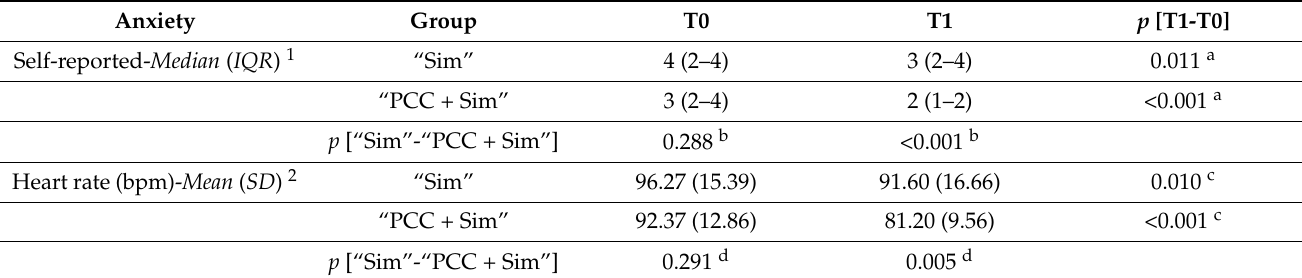
Table 2. Children’s anxiety levels before and after the intervention in the simulation group (without the PCC model) and in the PCC + simulation group.